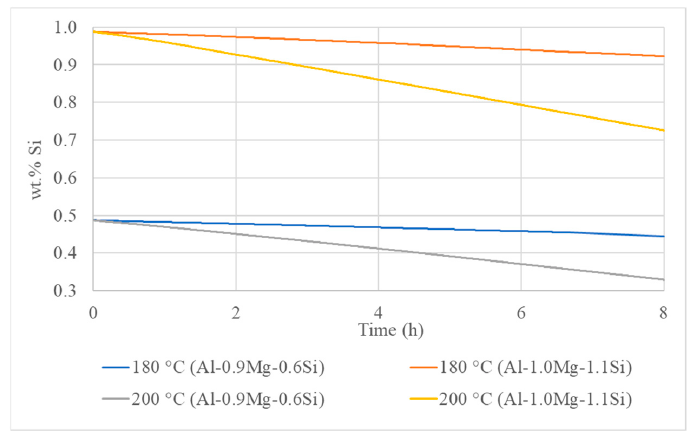
Figure 12. Evolution of available Si content in the matrix phase, based on Equation (10).